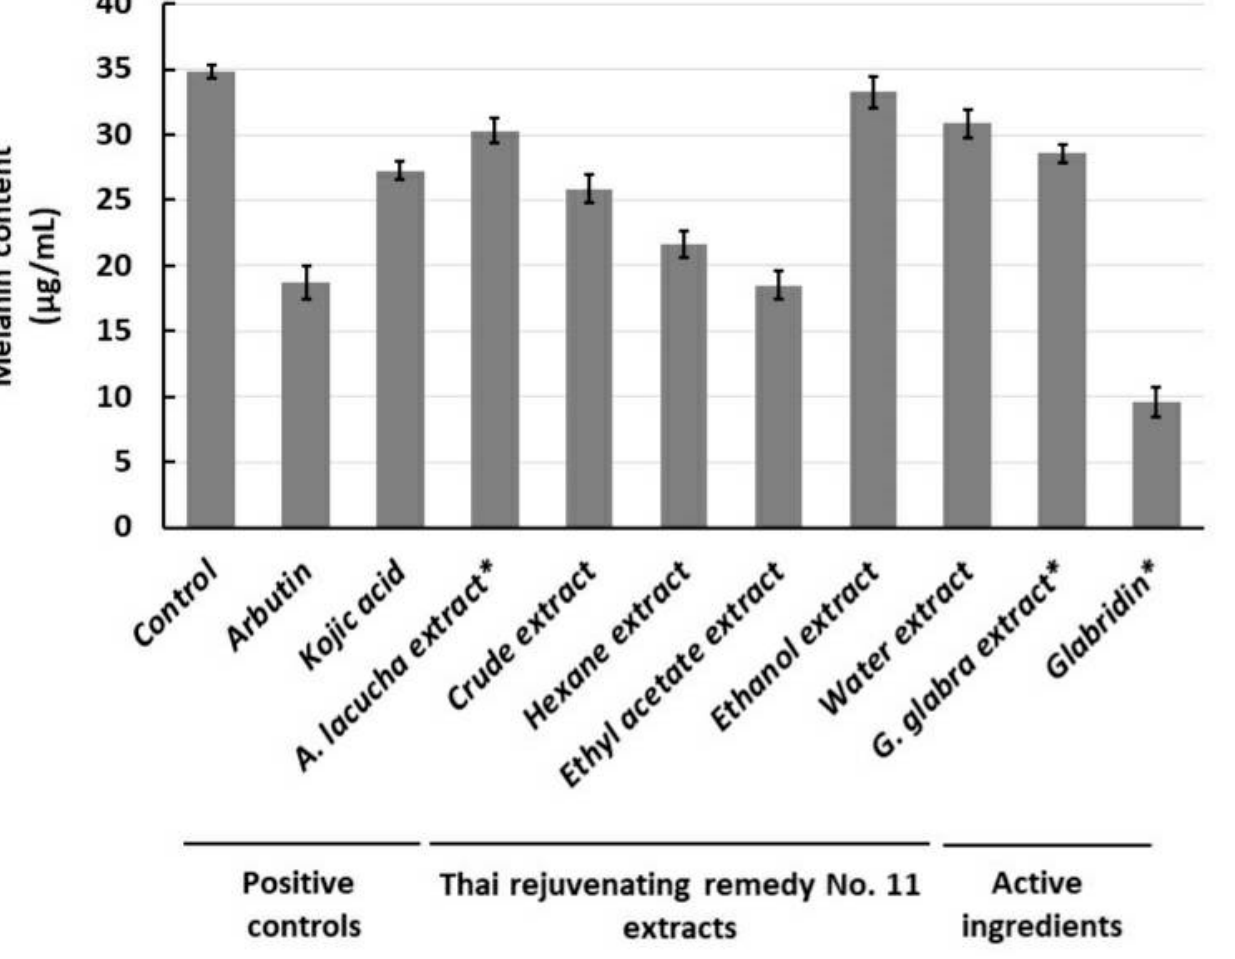
Figure 5. Melanin content of positive controls (arbutin, kojic acid, and A. lacucha wood extract), Thai rejuvenating remedy No. 11 extracts (crude, hexane, ethyl acetate, ethanol, and water extracts), and active ingredients ( G. glabra extract and glabridin) at concentrations of either 5 or 25 µ g/mL, according to sample toxicological profile. * Indicates samples tested at a concentration of 5 µ g/mL. All samples are tested in triplicate (N = 3).